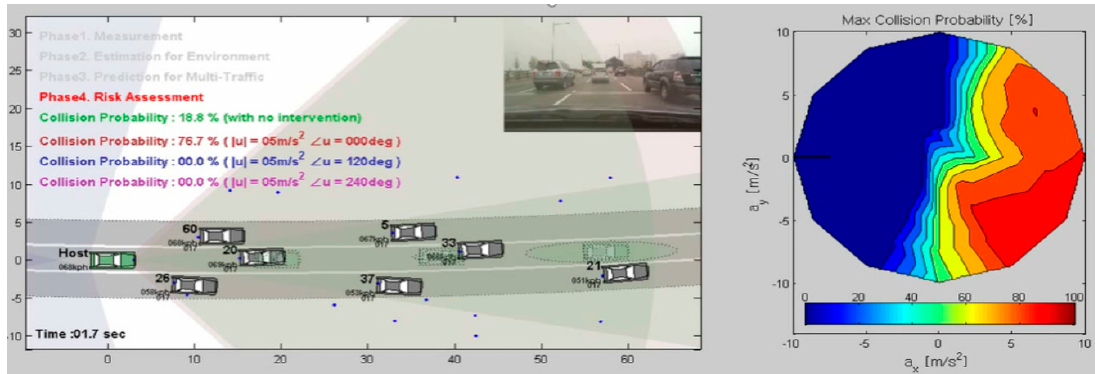
Figure 4. Multi-target state estimation test results for complex urban road.